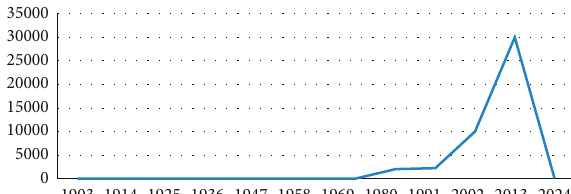
Figure 19: Article distribution by years for literature review